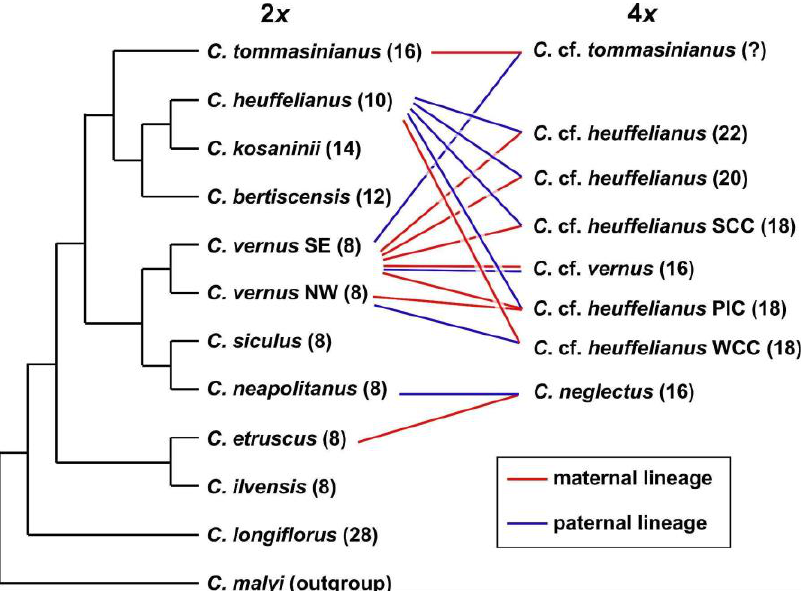
Figure 8. Schematic representation of species relationships in Crocus ser. Verni based on GBS, chloroplast, and nuclear single-copy gene data. For the tetraploids the maternal and paternal parents are indicated by lines connecting them to the respective diploid taxa. In brackets, chromosome numbers are provided.